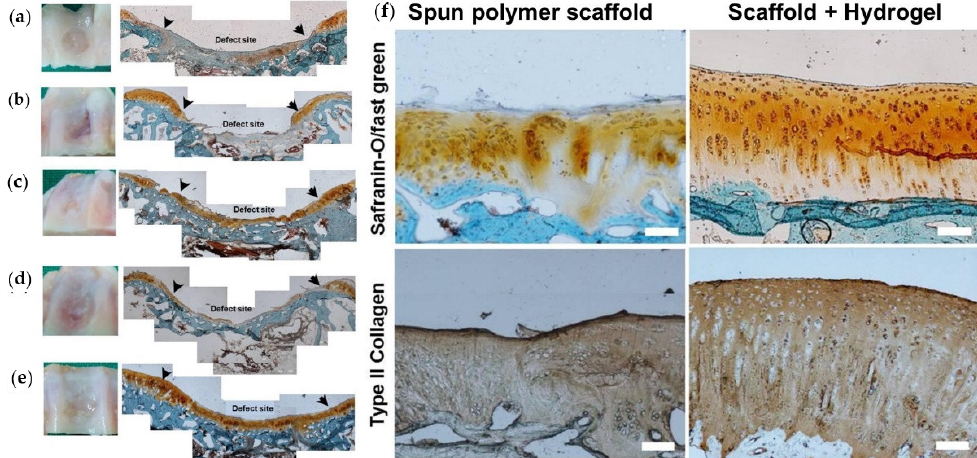
Figure 6. Photographs of the defect site and histological staining (safranin-O/fast green) of cryo- sectioned samples in rabbit knee at 4 months. ( a ) Control partial defect site; ( b ) electrospun polymer scaffold with no cell impregnation; ( c ) the same scaffold with cells; ( d ) the polymer scaffold/hydrogel without cells; and ( e ) the scaffold–hydrogel composite with cells. The arrows point to the borders of initial defect site. Finally, ( f ) photographs of histological (safranin-O/fast green) and immune-histochemical (type II collagen) stained images of cryo-sectioned samples in rabbit knee at 4 month after implantation of electrospun scaffolds or scaffold–hydrogel composites are shown with scale bars: 100 μm. Reproduced from [114] with permission.